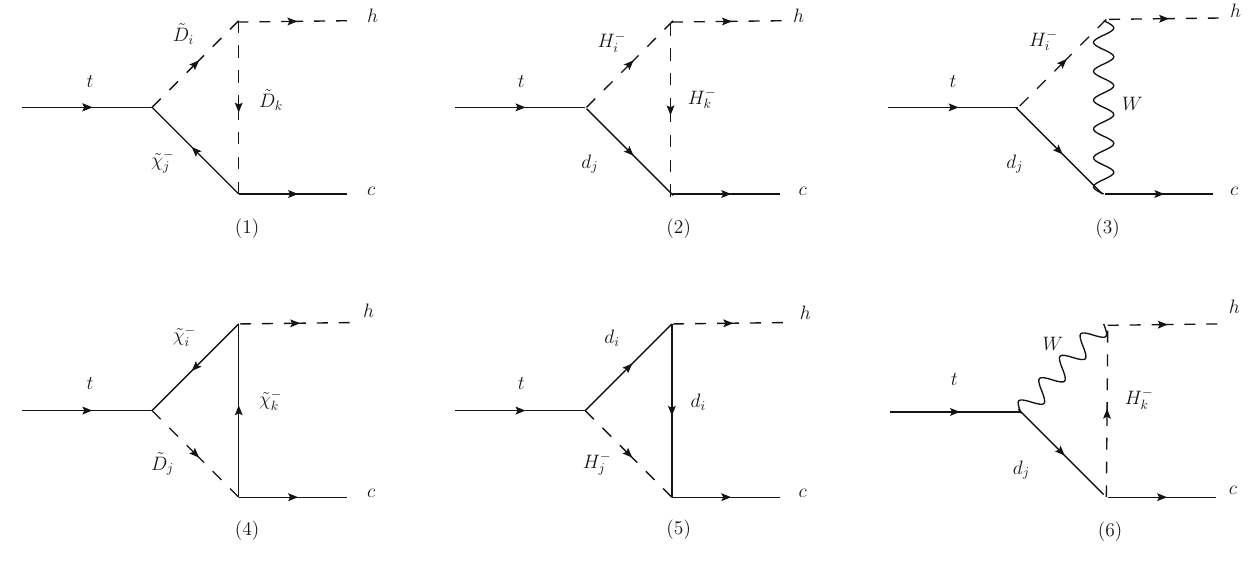
Fig. 2 The Feynman diagrams contributing to t → ch in the